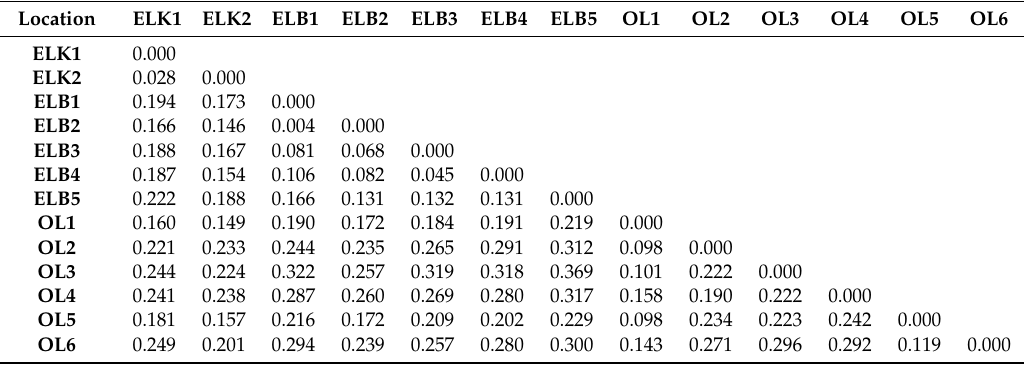
Table 4. Genetic differentiation Φ ST (below diagonal) between the analyzed locations of S. purpurea based on AFLP, RAPD and ISSR results.